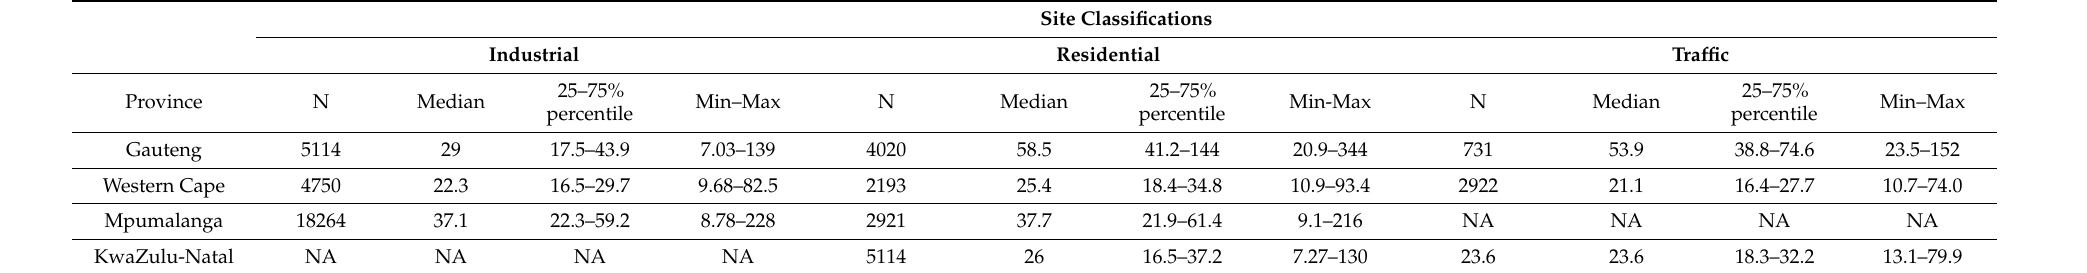
Table 2. The distribution of daily PM 10 concentration in µ g/m 3 by province and site